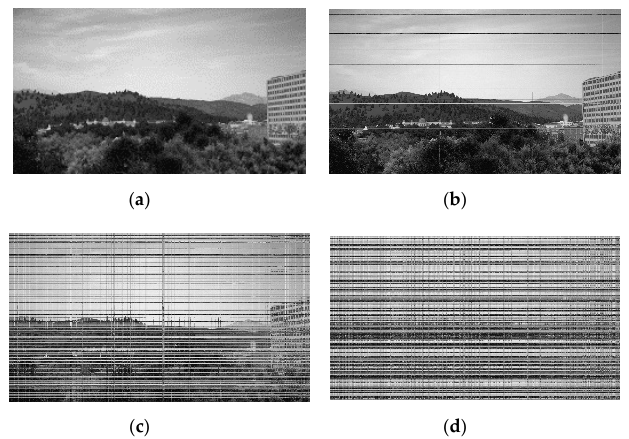
Figure 7. Original video frame and encrypted video frames: ( a ) original video frame and ( b ) 15 times permutated video frame. A human can easily recognize the frame content; ( c ) 126 times permutated video frame and ( d ) 307 times permutated video frame. A human cannot recognize the frame content. It has an MSE value of 100 when compared to the original frame.